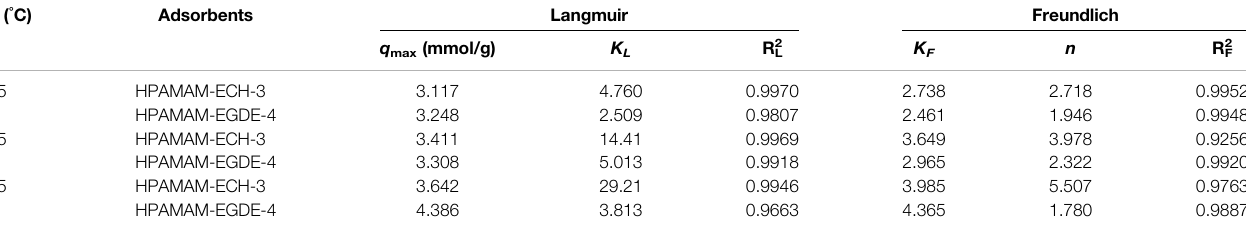
TABLE 5 | Langmuir and Freundlich isotherm constants for the adsorption of Hg(II) on HPAMAM-ECH-3 and HPAMAM-EGDE-4 at pH 5.0, 25 ° C. T ( ° C)